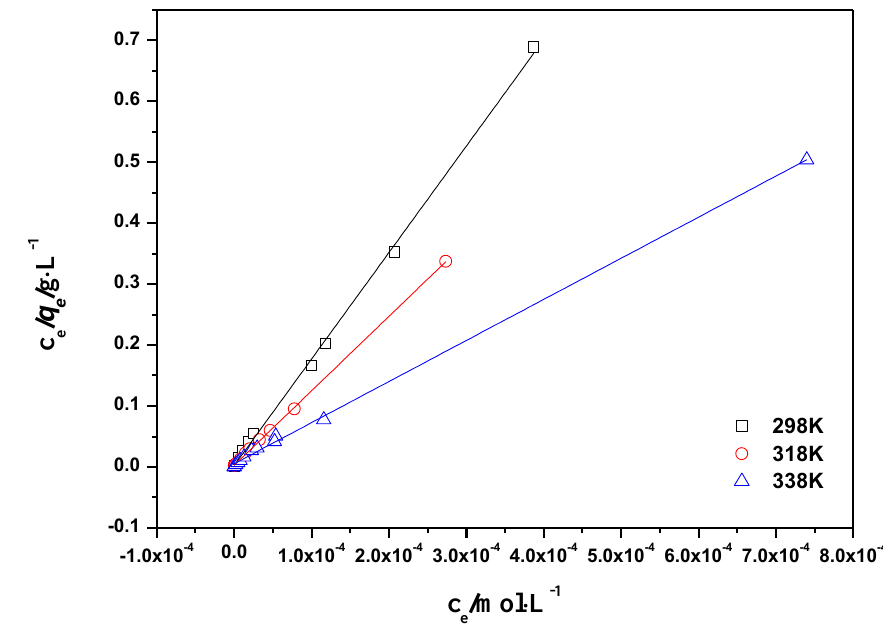
Figure 8. Langmuir model of Th(IV) adsorption onto oMWCNTs, m/V = 0.1 g/L,